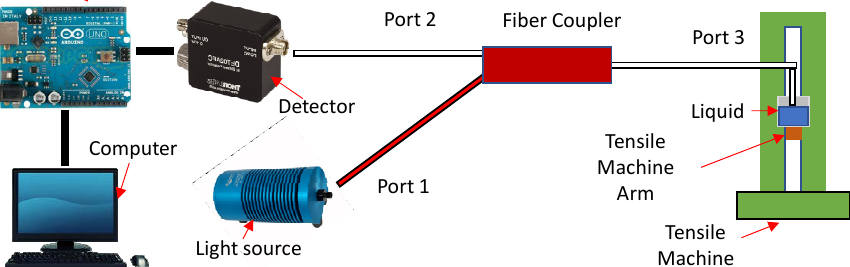
Figure 6. Depiction of setup used for measuring the CMH of a liquid with a different light source and the detector connected to the Arduino. A computer then reads the